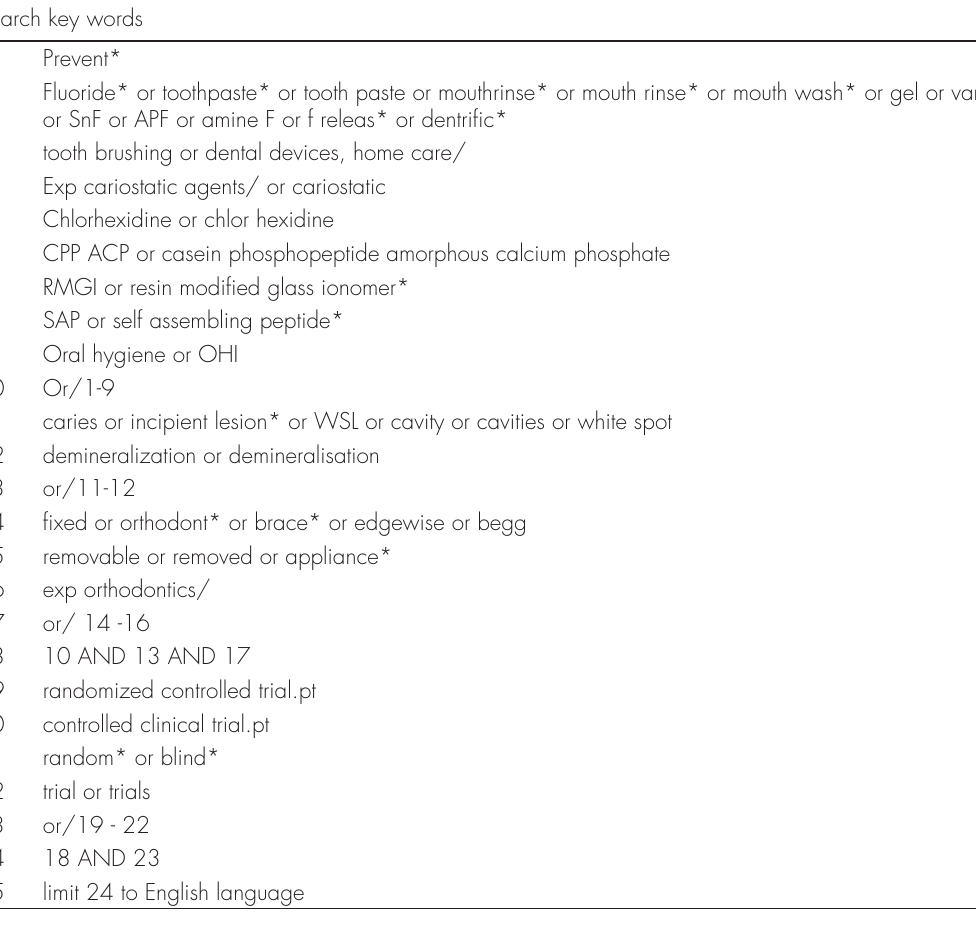
Supplementary Table I. MEDLINE OVID search